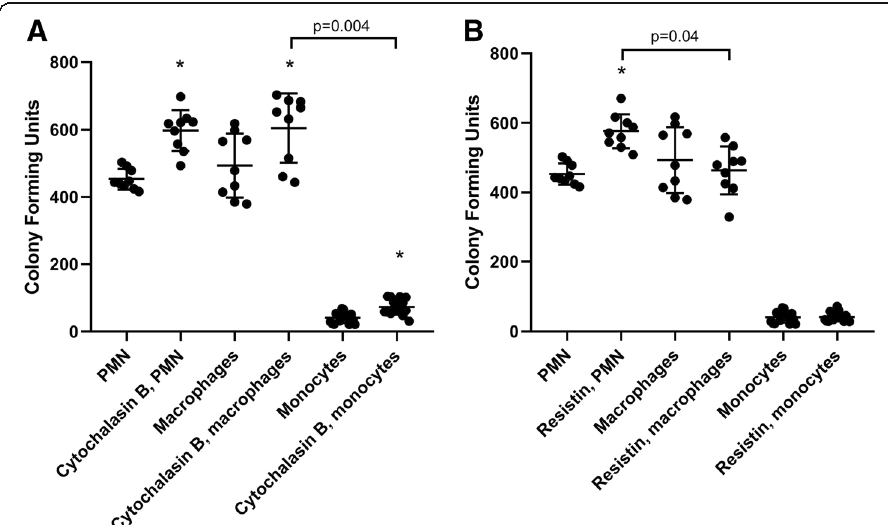
Fig. 2 Comparison of bacterial killing of S. aureus by PMN (neutrophils), macrophages, and monocytes in the presence of a cytochalasin B and b human resistin. Cytochalasin B significantly impaired the ability of all cell types to kill S. aureus ( P <0.001 in PMN, macrophages, and monocytes). Human resistin significantly impaired bacterial killing of S. aureus in neutrophils ( P <0.001) but not in monocytes ( P =0.34) or macrophages ( P =0.224). n =9 (PMN), 9 (macrophages), and 16 (monocytes). Statistically significant differences in bacterial killing capacity between different cell types to each stimulant are denoted by P values on the graph. Asterisk denotes statistical significance ( P